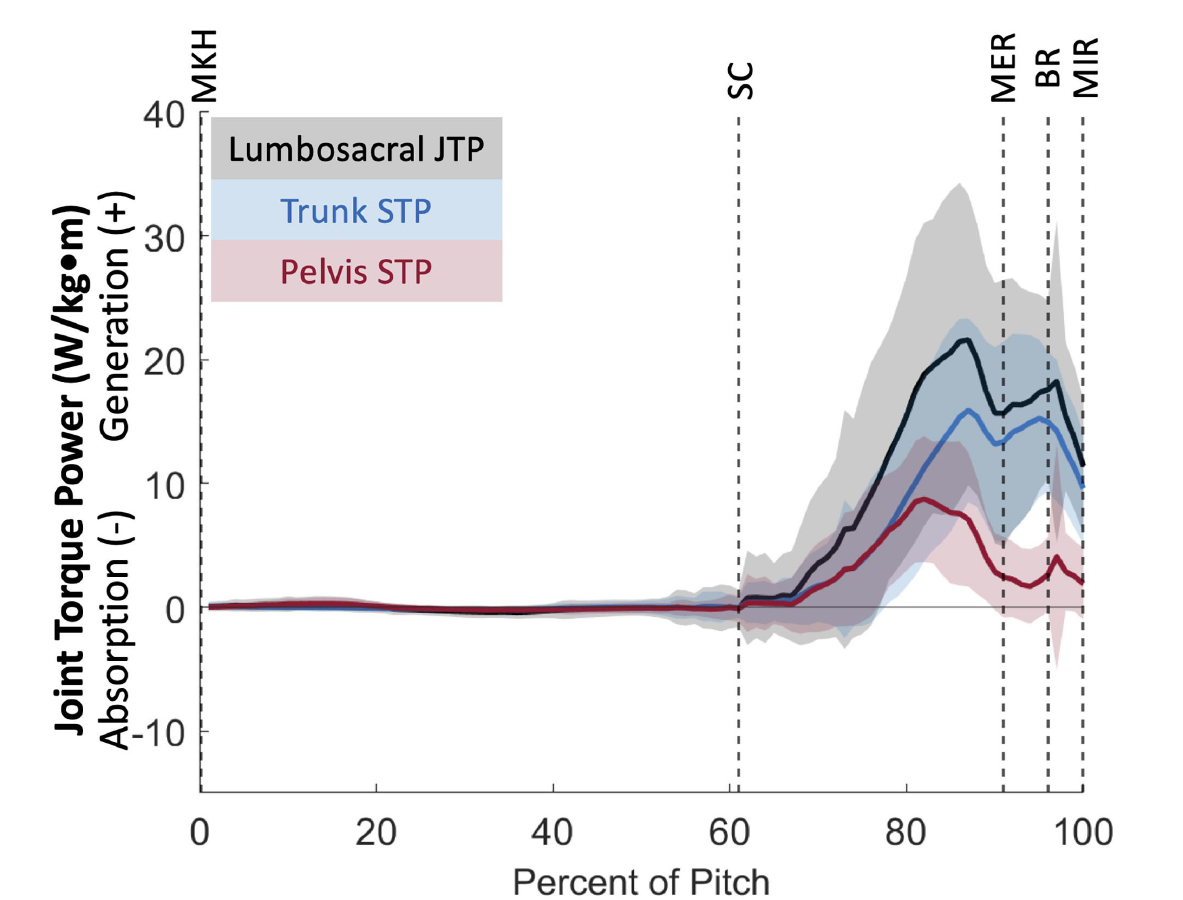
FIGURE10 Mean ± SD joint torque power for the lumbosacral joint (black) and its components of trunk segment torque power (blue) and pelvis segment torque power (red) for the duration of the pitch from maximum knee height (MKH) to maximum internal rotation